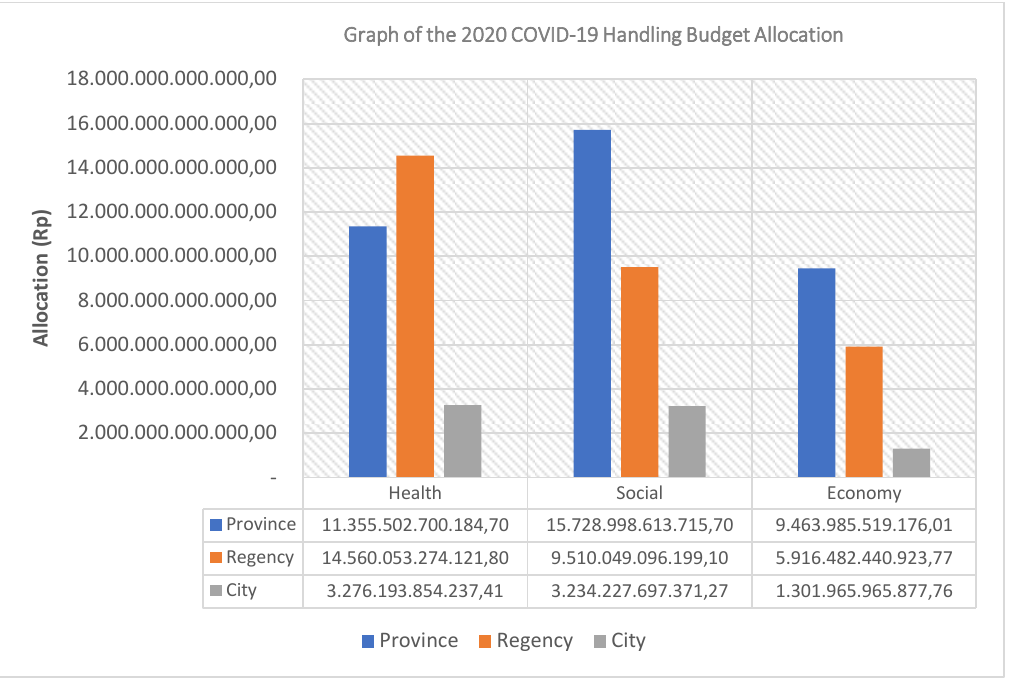
Graph 1: the Budget Allocation to Handle COVID-19 in 2020 in